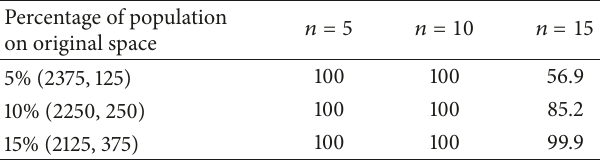
Table 7: Percentage of PDS in the final population for the con- current search approach changing the population ratio between extended and original space. 𝑀 = 4 , overall population size |𝑃| = 2500